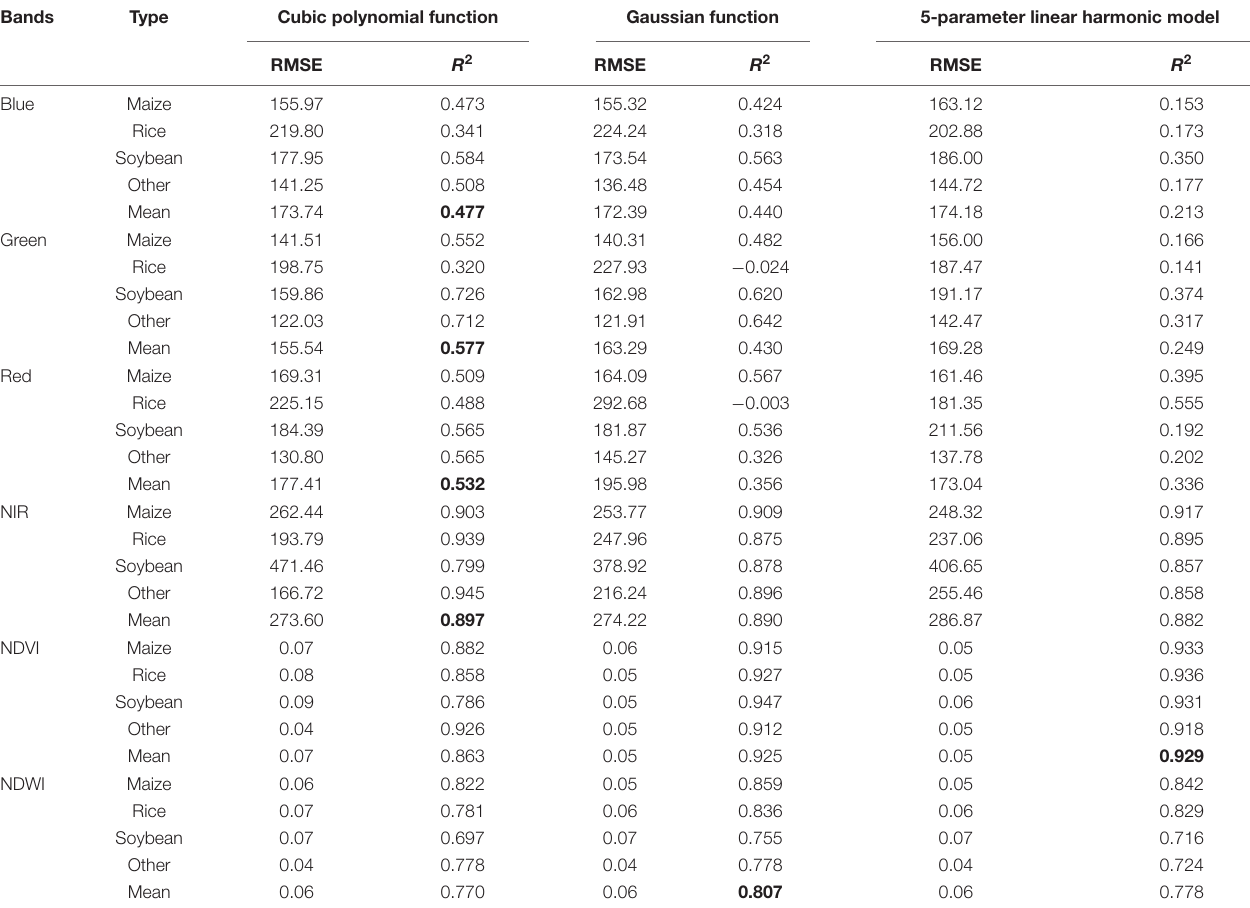
TABLE 3 | Curve fitting